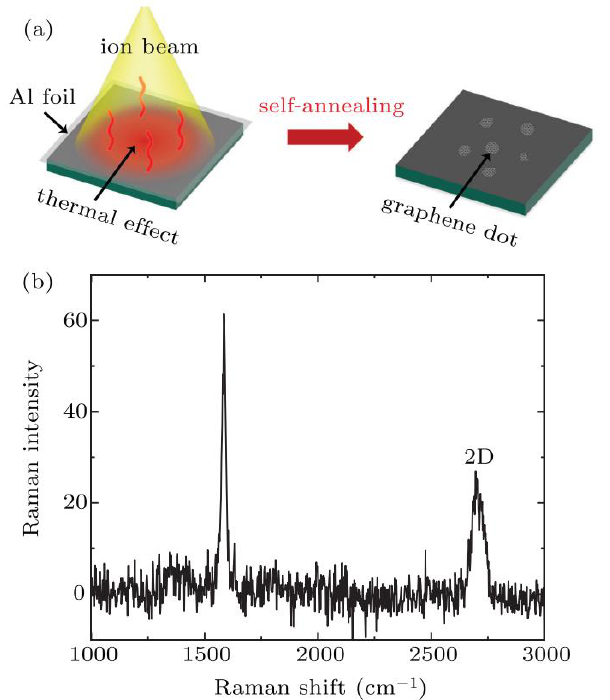
Figure 13. ( a ) Schematic diagram of self-annealing graphene prepared by the thermal effect of laser- accelerated ion beam irradiation at a closer irradiation distance (d ≤ 1 cm). ( b ) Raman spectrum of 1 cm-100-shot SiC sample with self-annealing (baseline drift corrected).